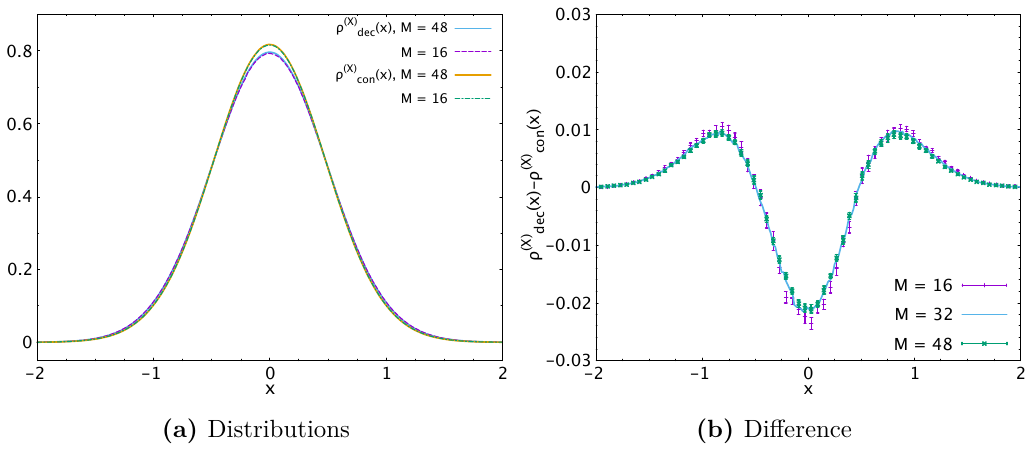
Figure 16. Yang-Mills matrix model, constrained simulations, N = 64 , L = 24 , T = 0 . 885 . Comparison between ρ (X) ( x ) and ρ (X) con ( x ) showed in figure 15. (a) A small difference between dec ρ (X) ( x ) and ρ (X) con ( x ) is visible. (b) The difference ρ (X) ( x ) − ρ (X) con ( x ) is significantly larger than the dec dec error bars of ρ (X) ( x ) and ρ (X) con ( x ) . The error bars in each figure are obtained by jackknife dec